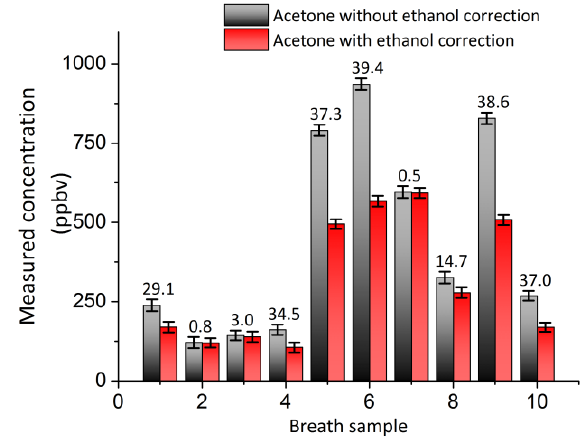
Figure 6. Comparison of measured acetone concentration at 1216 . 5 cm −1 from 10 breath samples without correction for ethanol (left bars, black) and with (right bars, red). Numbers on top give the relative error of acetone concentration if the presence of ethanol is not considered.